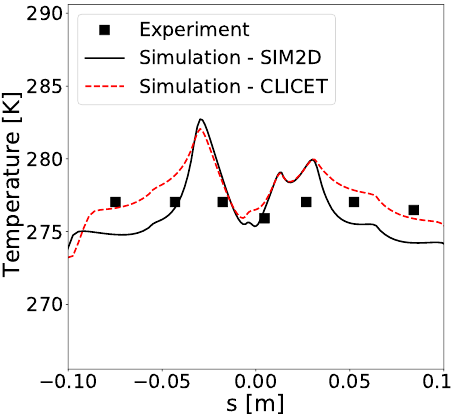
Figure 12. Comparison between experimental data and numerical results for anti-icing Case